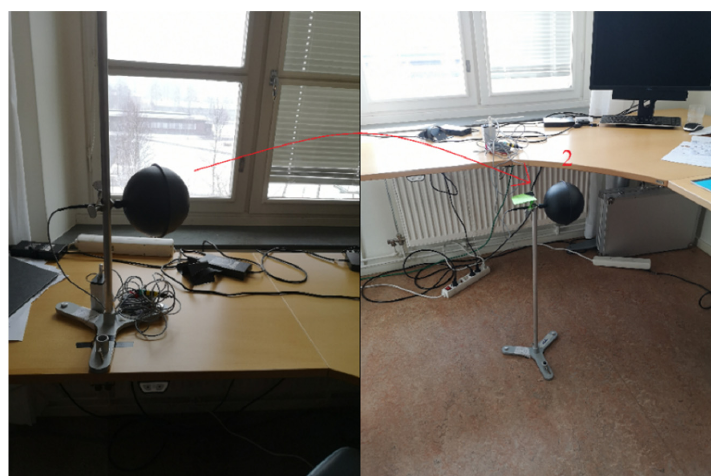
Figure 10. Placement of the globe thermometer in its first and second placements in Room B.